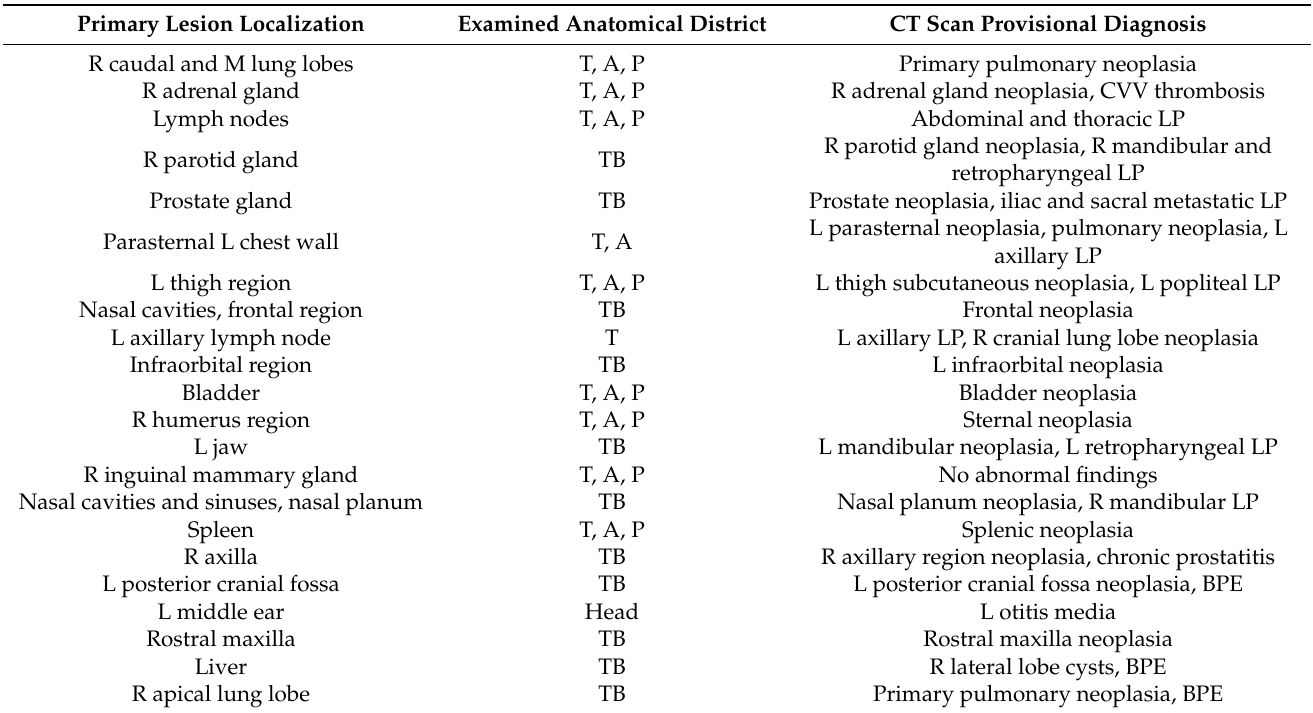
Table 1. Primary lesion localization, examined anatomical districts, and the computed tomography (CT) scan provisional diagnosis of 22 dogs.